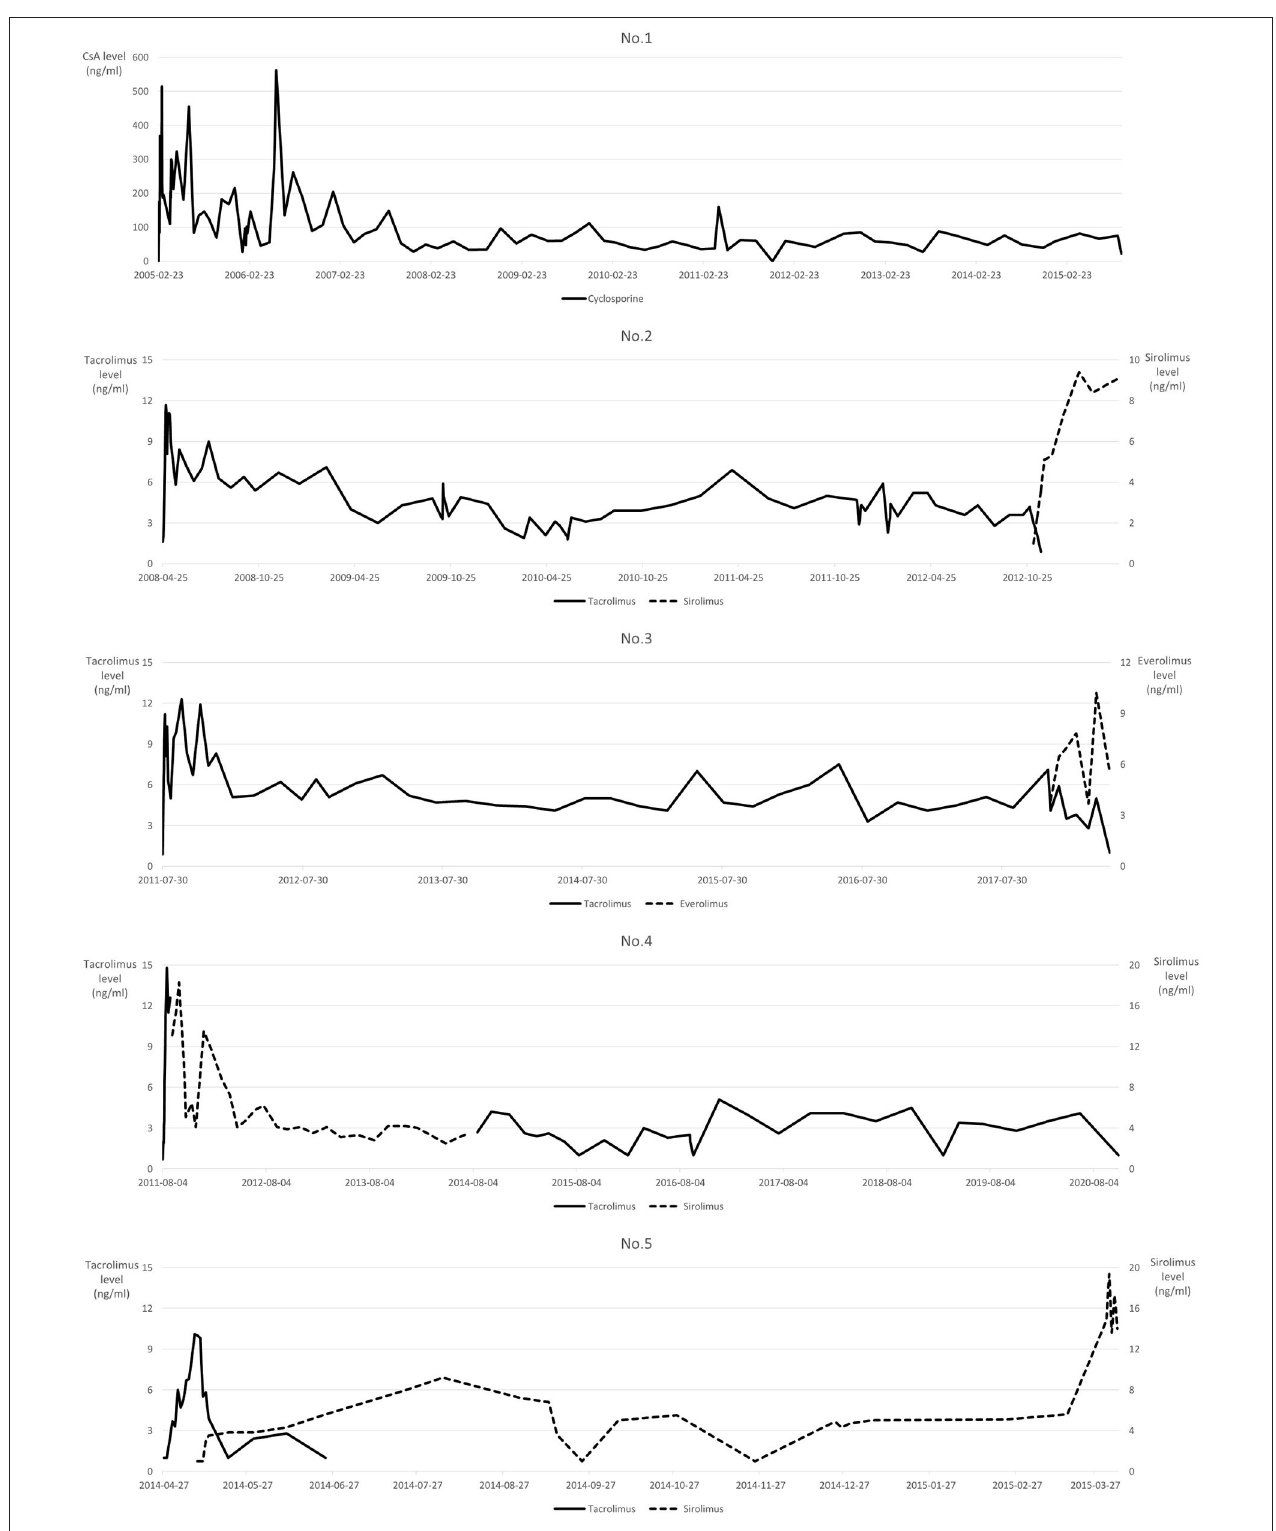
FIGURE 4 | Serum immunosuppressant levels. Non-measurable Tacrolimus values < 2ng/ml are labeled as 1ng/ml.